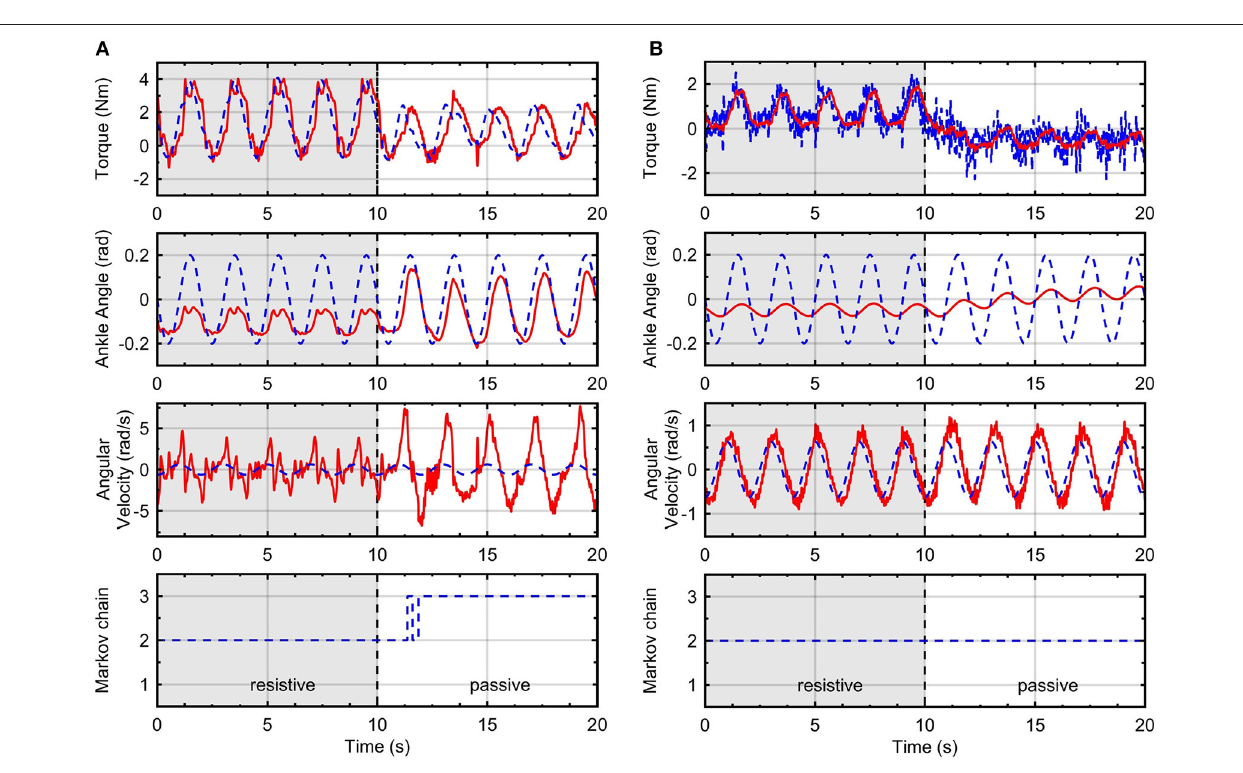
FIGURE 10 | Impedance control with inner RR-DMJLS force control. Torque and impedance control responses for: (A) K v = 15 N · m / rad and B v = 0 N · m · s / rad, and (B) K v = 15 N · m / rad and B v = 5 N · m · s / rad. Graphs show desired (blue) and measured (red) values for the platform torque (top), angular position of the ankle joint (middle-top), angular velocity of the ankle joint (middle-bottom); and Markov chain